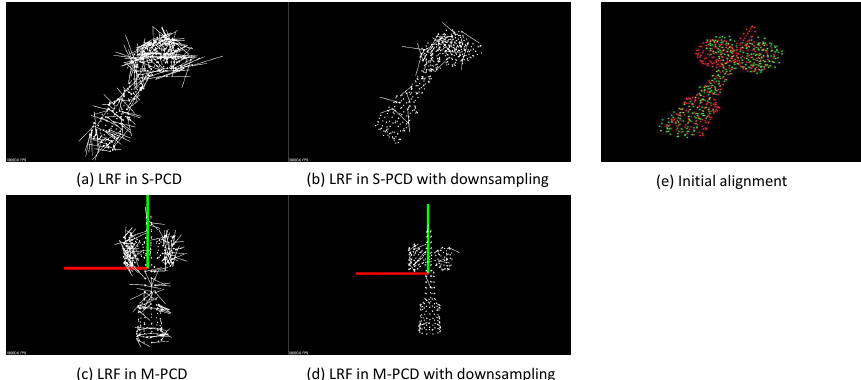
Figure 22. Result of initial